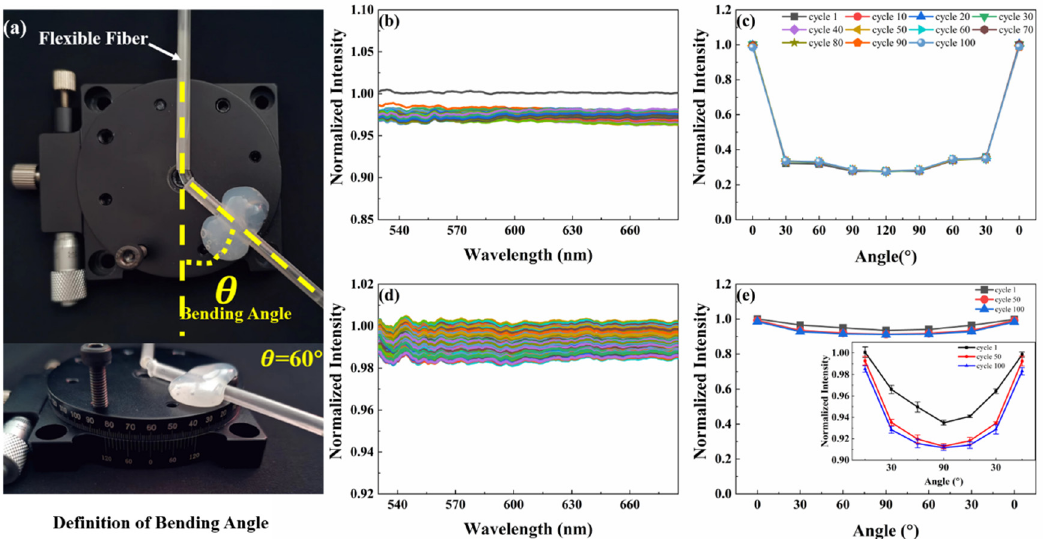
Figure 4. Bending and torsion-sensing performances of the flexible optical fiber. ( a ) Definition of bending angle. ( b ) The flexible fiber is cyclically bent 50 times in the range of 0~120° bending angle. The different color lines represent each bending cycle. ( c ) The angle-normalized intensity curve at 10 intervals during the 10th to 100th cycles and the 1st cycle in the bending test. ( d ) The flexible fiber is repeatedly twisted 50 times in the range of 0~90° torsion angle. The different color lines represent each torsion cycle. ( e ) The angle-normalized intensity curves during the 1st, 50th and 100th cycles in the torsion test.